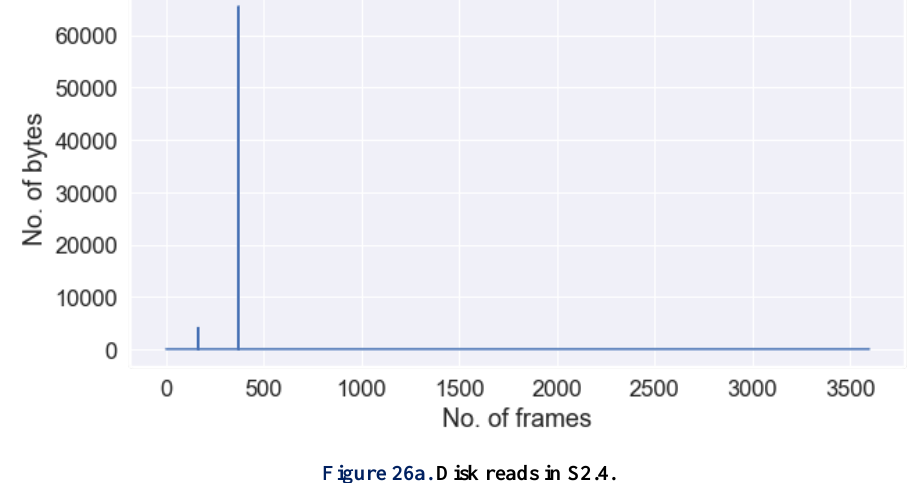
Figure 26a. Disk reads in S2.4.